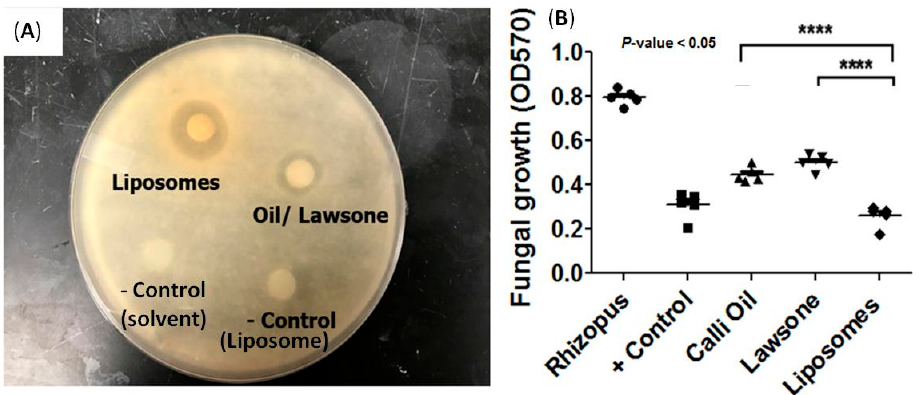
Figure 6. The antifungal effect of liposomes compared to the combined treatment and individual